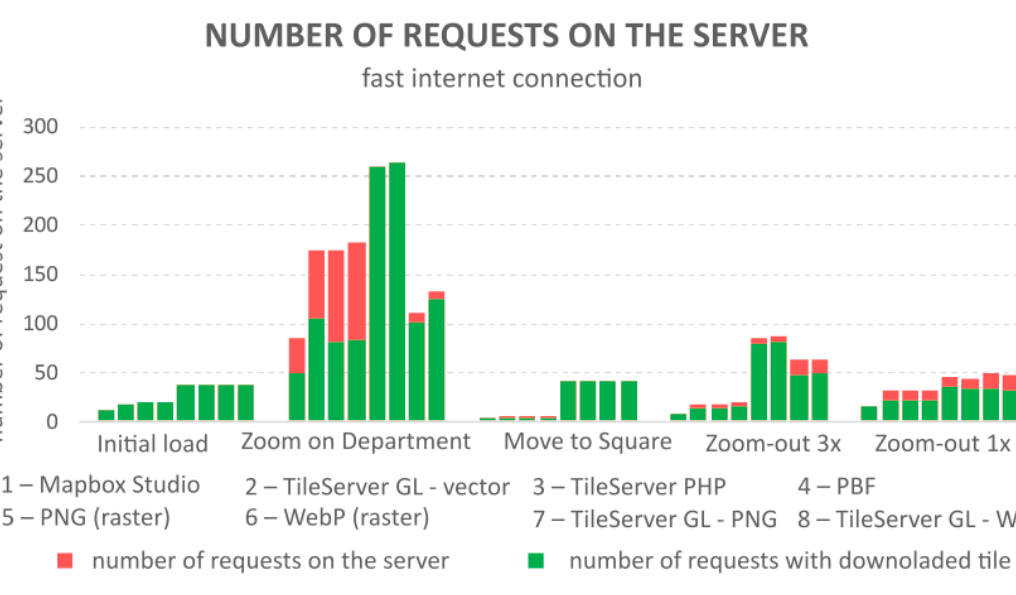
Figure 9. Results of the number of requests on the server (fast Internet connection).